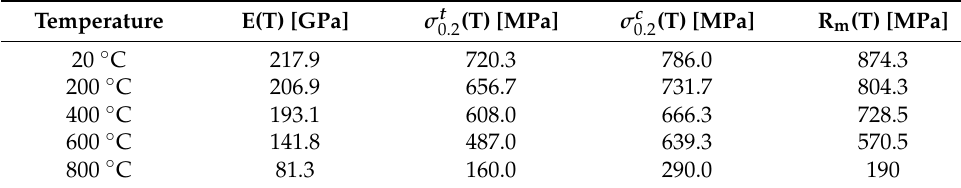
Table 1. St12T steel mechanical properties